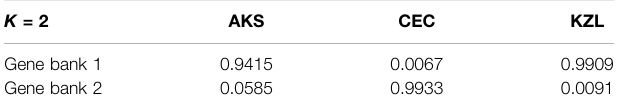
TABLE 8 | Proportion of ancestry of each population in three gene pools de fi ned with the model-based clustering method. K =